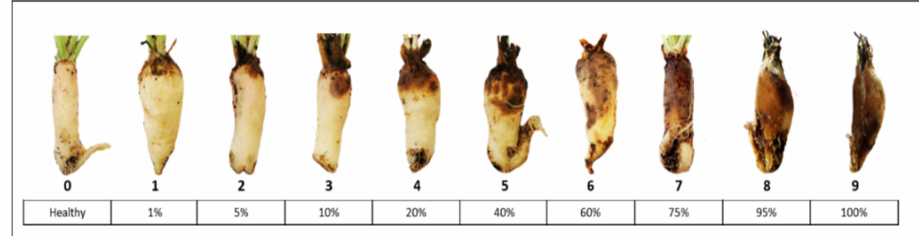
Figure 1. Disease scale used to score Rhizoctonia root and crown rot in sugar beet based on the percentage of rotten root surface area.